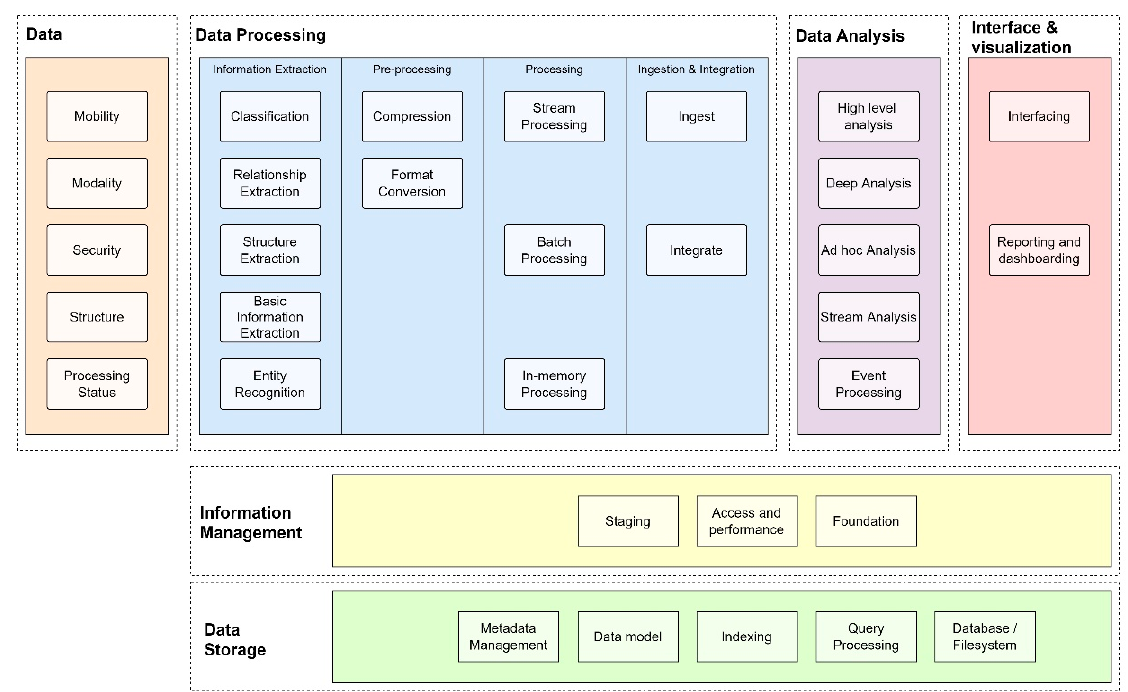
Figure 5. General architecture of Big Data.